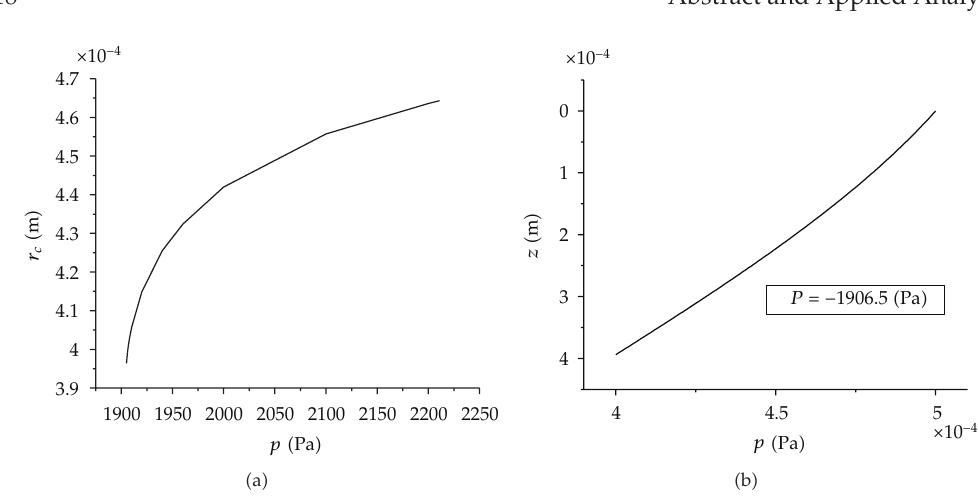
(cid:8) 1 . 4rad. (cid:6) b (cid:7) The concave meridian curve for p (cid:8) 1906 . 5Pa, c